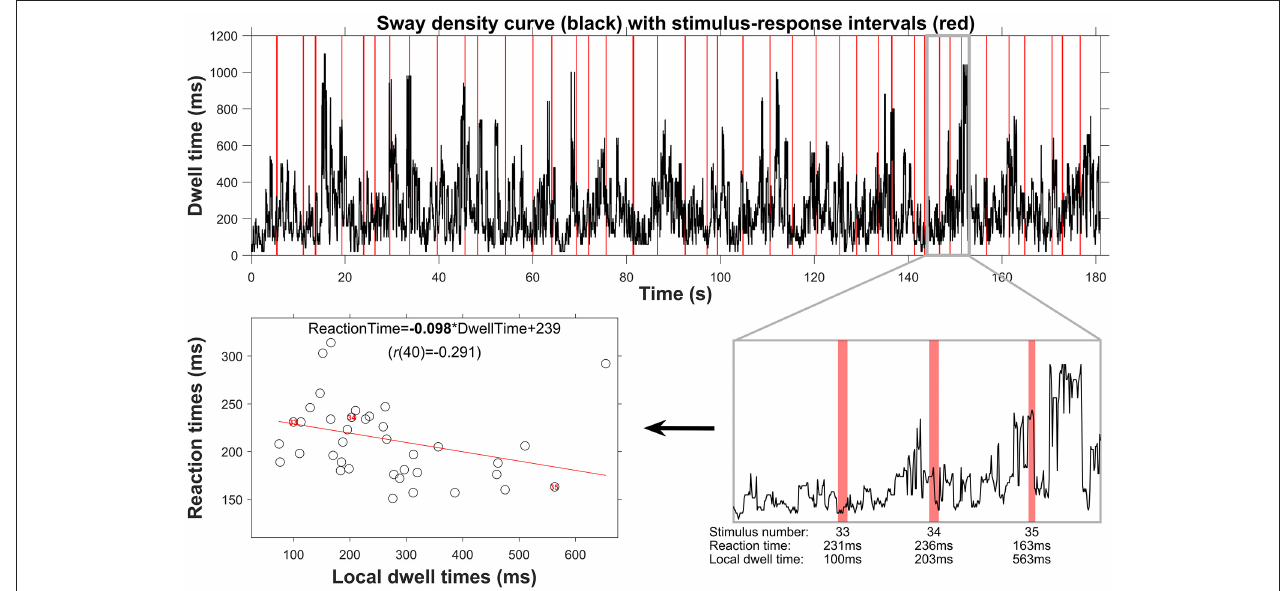
FIGURE 2 | Procedure outlining the posturographic analyses from global to local dwell-time estimation, and their relation to stimulus-response reaction times. The top panel displays the sway density curve, with in red the 41 episodes corresponding to stimulus-response intervals. Over the whole trial, the dwell time was on average 248ms, but dwell times clearly fluctuate throughout the trial, with peaks up to 1,000ms. In the lower-right panel, the sway-density curve is depicted for a period of about 10s, containing three stimulus-response pairs (numbers 33, 34, and 35). As can be seen, the local dwell times taken over the stimulus-response intervals, as well as the reaction-time values, vary. This is confirmed by the negative correlation between local dwell times and reaction times, as depicted in the lower-left panel, with the linear fit (red line) and its regression equation yielding an overall negative slope (presented in bold font) for this trial.